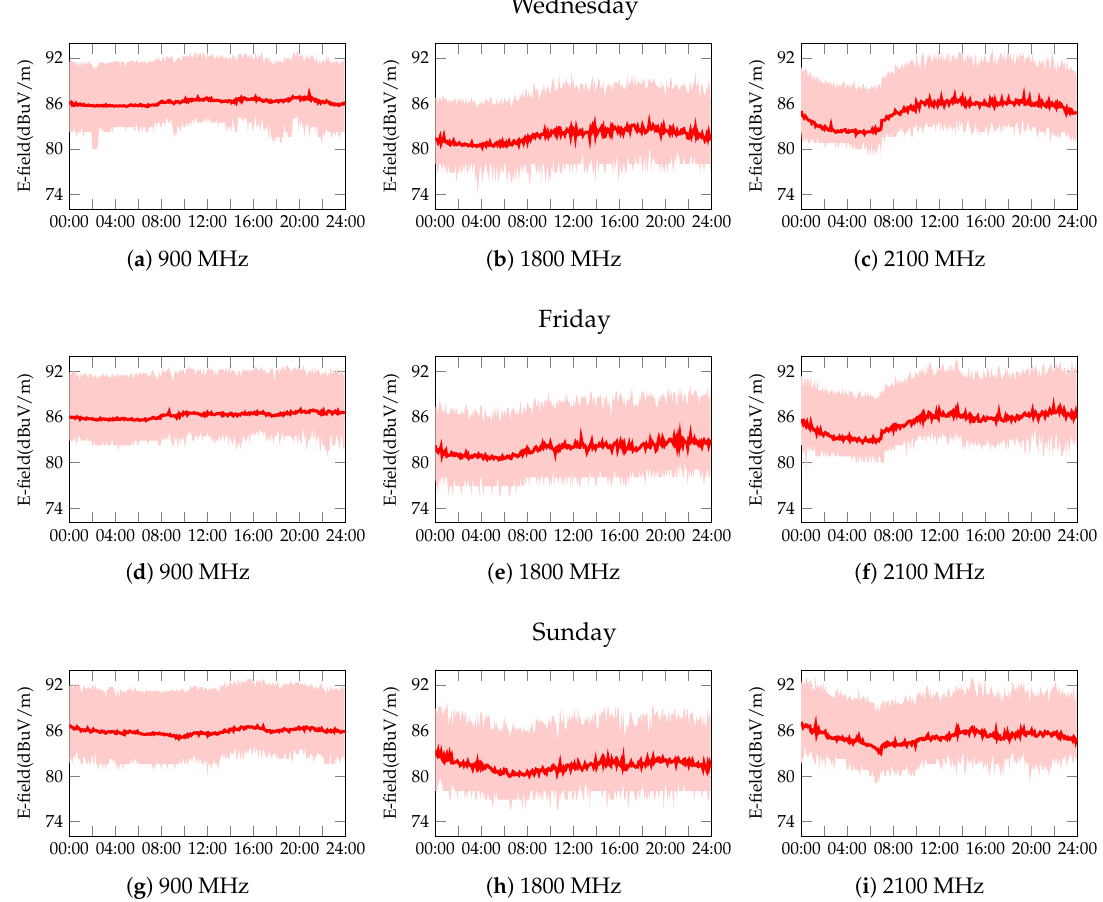
Figure 10. Average value of the E-field during a day; each point is obtained every five minutes. Upper and lower values represent the confidence